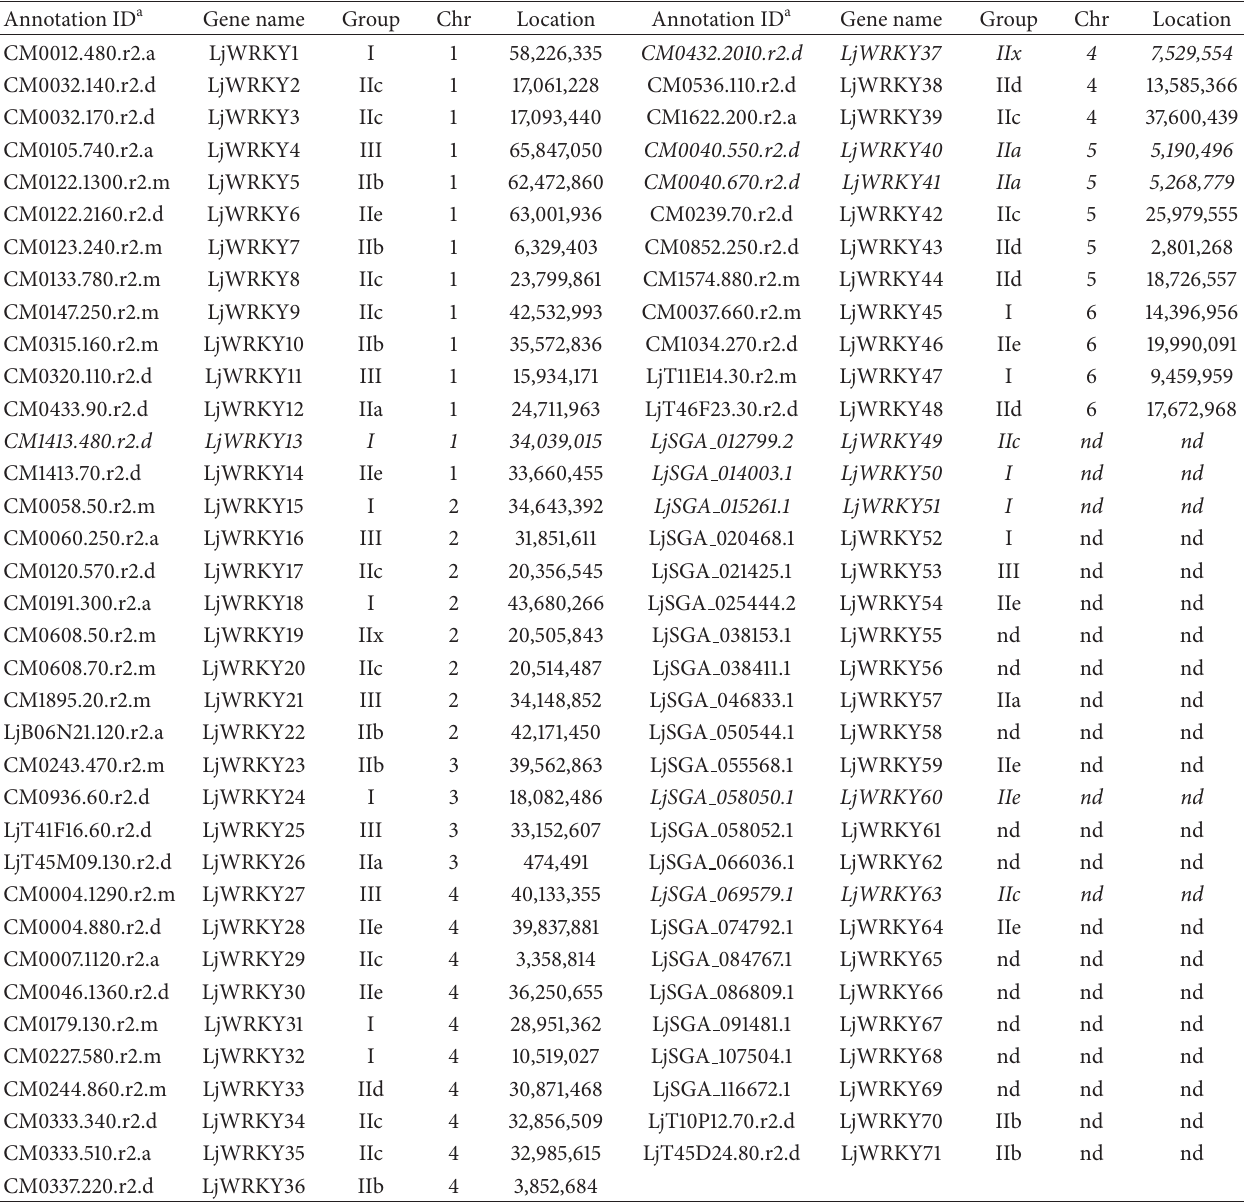
Table 1: WRKY family genes in Lotus japonicus